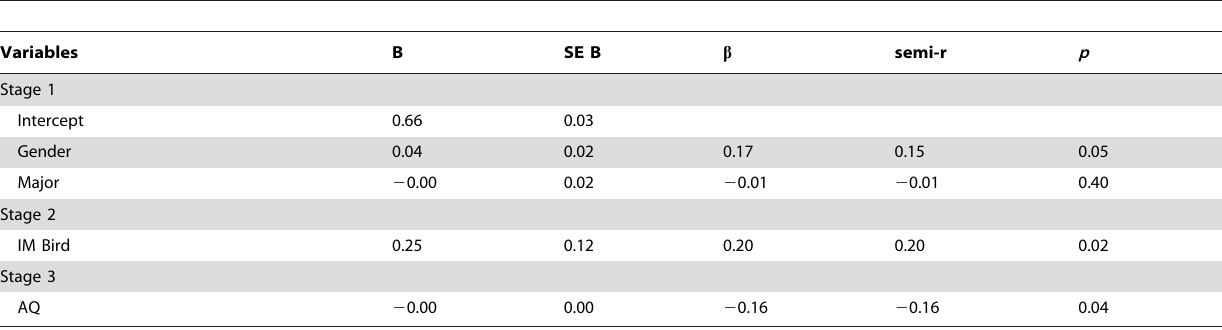
Table 3. Hierarchical regression on face recognition scores as a function of university major, gender, bird recognition and Autism